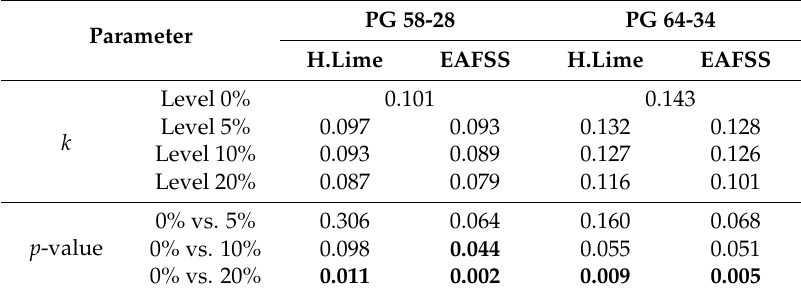
Table 3. Huet Model Parameters k : statistical comparison for PG 58-28 and PG 64-34 binder.